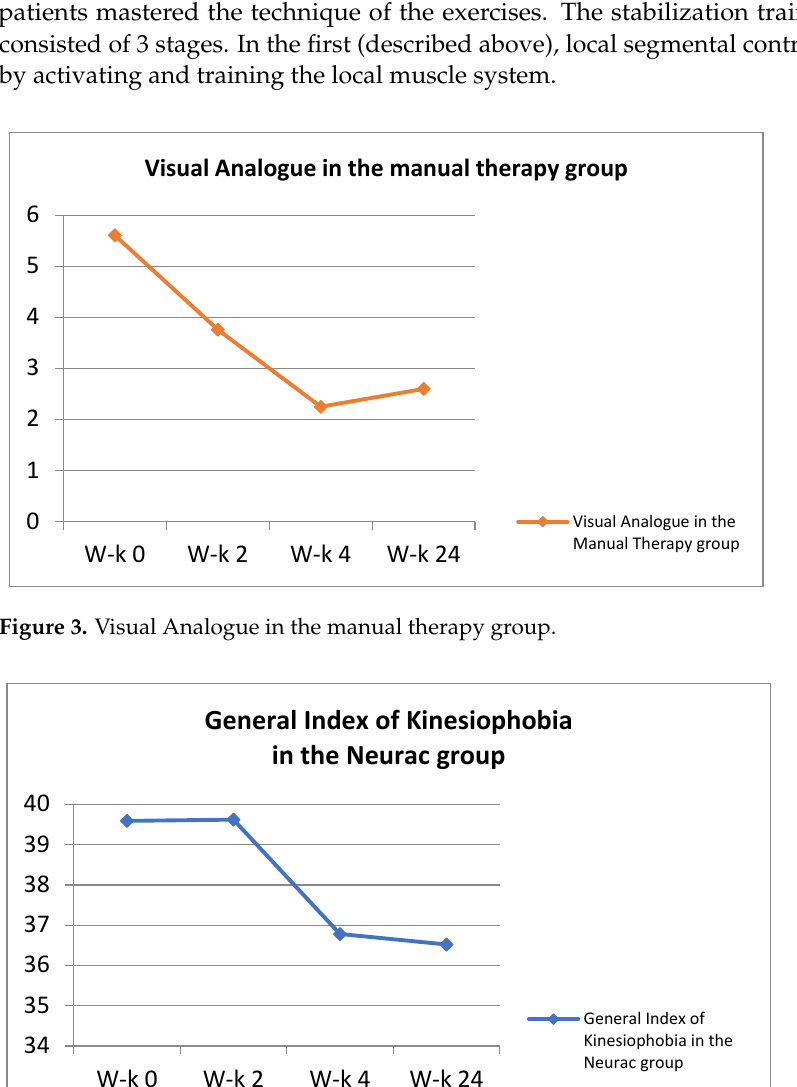
Figure 5. Visual Analogue in the Neurac group.